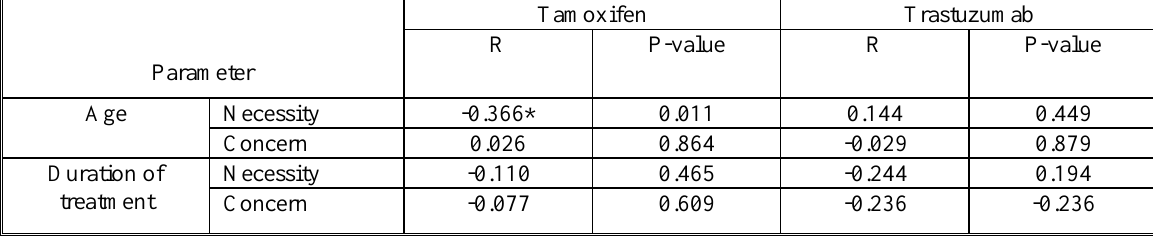
Table 6. The correlation between age, duration of treatment and necessity or concern scale for both Tamoxifen and